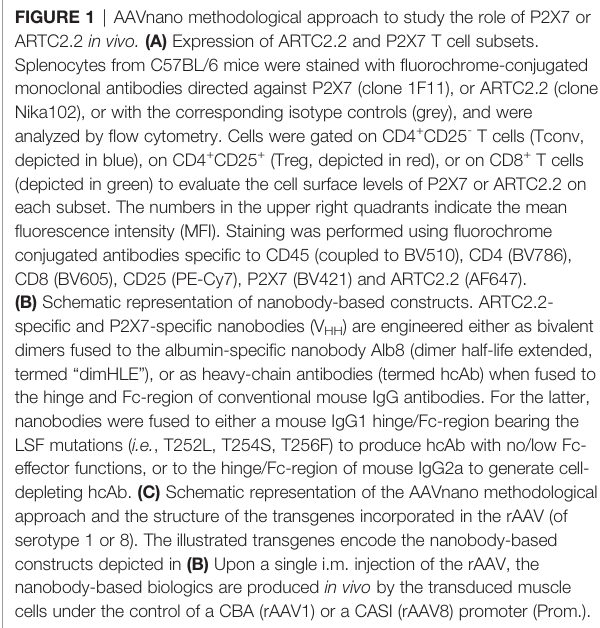
FIGURE 1 | AAVnano methodological approach to study the role of P2X7 or ARTC2.2 in vivo. (A) Expression of ARTC2.2 and P2X7 T cell subsets. Splenocytes from C57BL/6 mice were stained with fl uorochrome-conjugated monoclonal antibodies directed against P2X7 (clone 1F11), or ARTC2.2 (clone Nika102), or with the corresponding isotype controls (grey), and were analyzed by fl ow cytometry. Cells were gated on CD4 + CD25 - T cells (Tconv, depicted in blue), on CD4 + CD25 + (Treg, depicted in red), or on CD8 + T cells (depicted in green) to evaluate the cell surface levels of P2X7 or ARTC2.2 on each subset. The numbers in the upper right quadrants indicate the mean fl uorescence intensity (MFI). Staining was performed using fl uorochrome conjugated antibodies speci fi c to CD45 (coupled to BV510), CD4 (BV786), CD8 (BV605), CD25 (PE-Cy7), P2X7 (BV421) and ARTC2.2 (AF647). (B) Schematic representation of nanobody-based constructs. ARTC2.2- speci fi c and P2X7-speci fi c nanobodies (V HH ) are engineered either as bivalent dimers fused to the albumin-speci fi c nanobody Alb8 (dimer half-life extended, termed “ dimHLE ” ), or as heavy-chain antibodies (termed hcAb) when fused to the hinge and Fc-region of conventional mouse IgG antibodies. For the latter, nanobodies were fused to either a mouse IgG1 hinge/Fc-region bearing the LSF mutations ( i.e. , T252L, T254S, T256F) to produce hcAb with no/low Fc- effector functions, or to the hinge/Fc-region of mouse IgG2a to generate cell- depleting hcAb. (C) Schematic representation of the AAVnano methodological approach and the structure of the transgenes incorporated in the rAAV